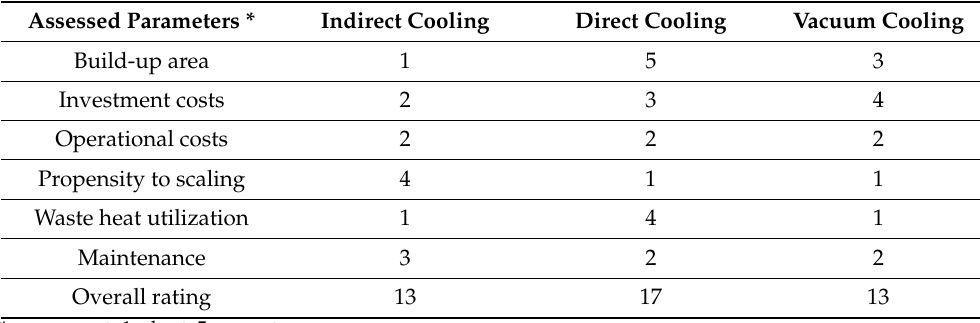
Table 2. Evaluation of selected cooling technologies. Assessed Parameters * Indirect Cooling Direct Cooling Vacuum Cooling Build-up area 1 5 3 Investment costs Operational costs Propensity to